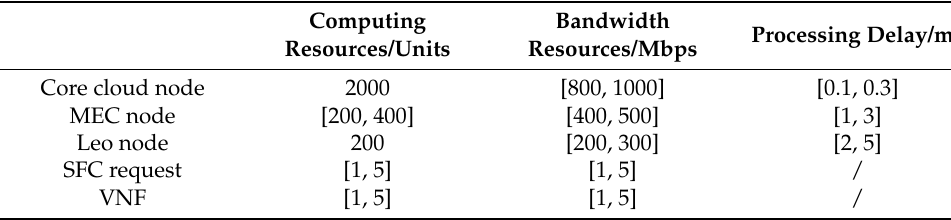
Table 3. Simulation parameters of service